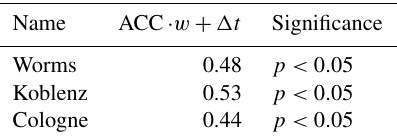
Table 7. Spearman’s rank correlation coefficients between RBT and GDP change for ACC · w + (cid:49)t . The last column shows the signifi-